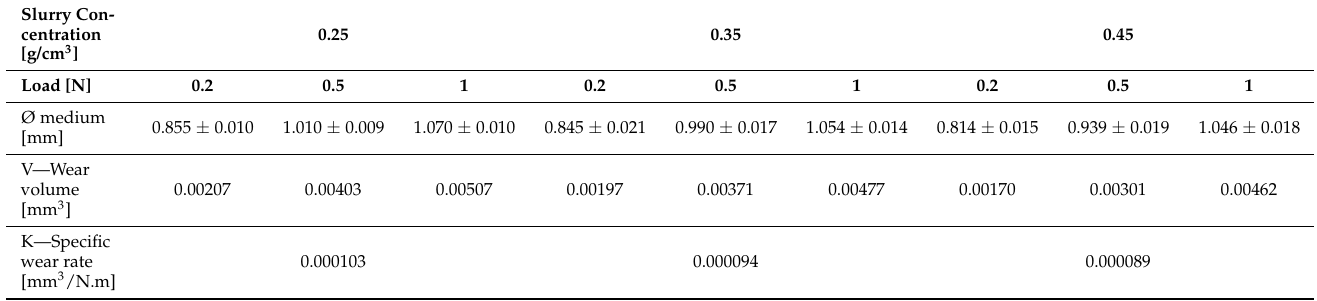
Table 3. Mean crater diameters; wear volume, specific wear rate of the scars produced by micro-scale abrasion equipment as a function of the loads and concentrations of abrasive slurry used.